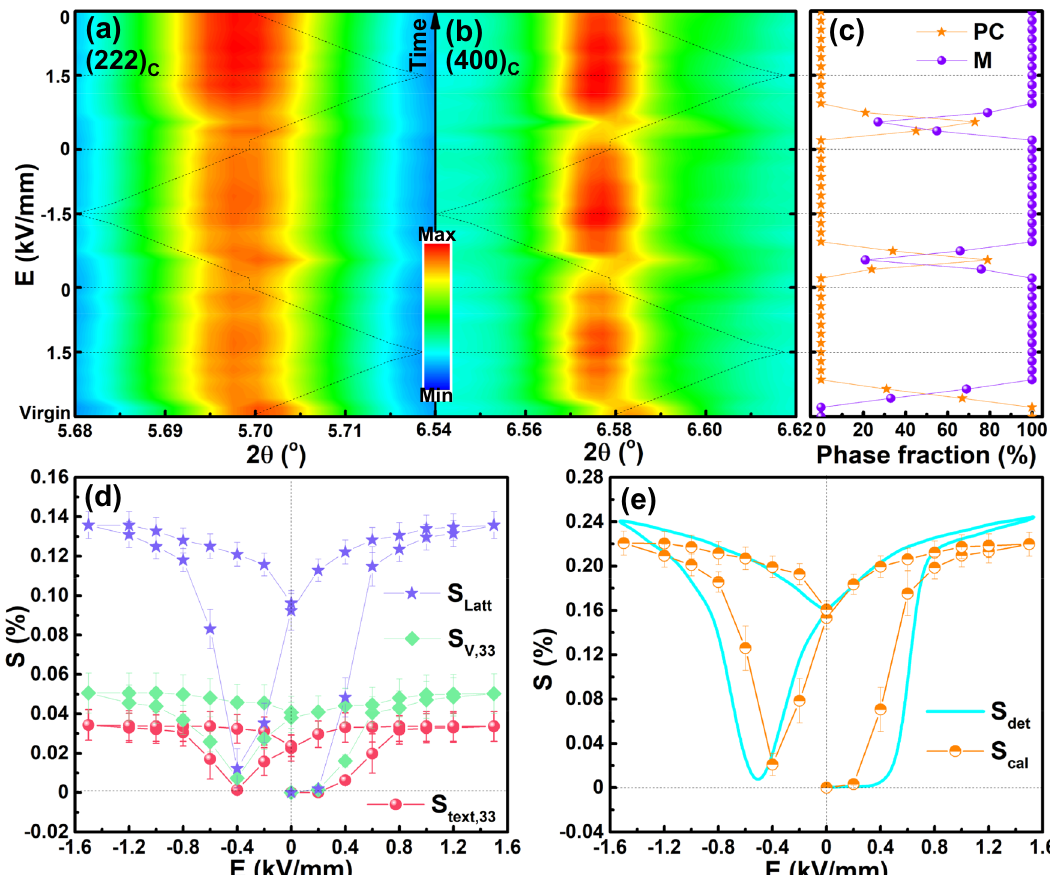
Fig. 5 | Quanti fi cation of structure evolution under electric fi eld. Evolution of a (222) C , b (400) C diffraction lines and c phase fraction for PL 8.3 Z 66 T 34 sample under different external electric fi elds. Quanti fi cation of d lattice strain S latt